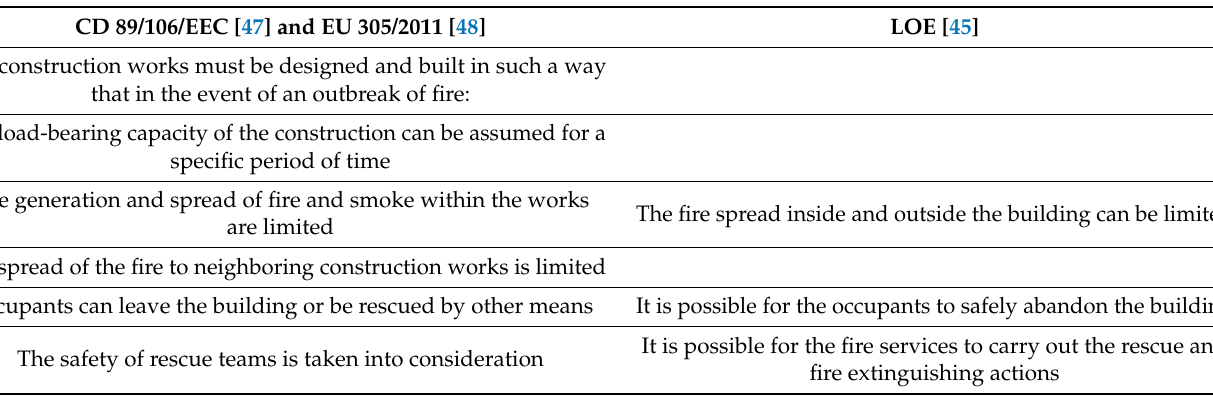
Table 3. Correspondence between the essential requirements of fire safety laid down by 89/106/EEC [47] and EU N305/2011 of 9 March 2011 [48] and by the Spanish Building Management Law (LOE) [14]. CD 89/106/EEC [47] and EU 305/2011